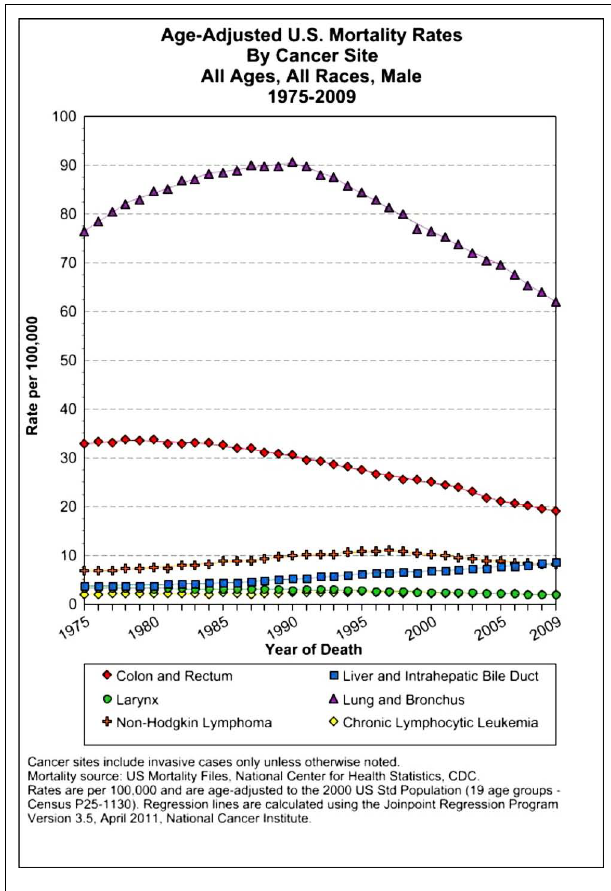
FIGURE 4 |Age-adjusted mortality rates for specific cancer types in males, all races combined, US SEER data (Howlader etal., 2011).